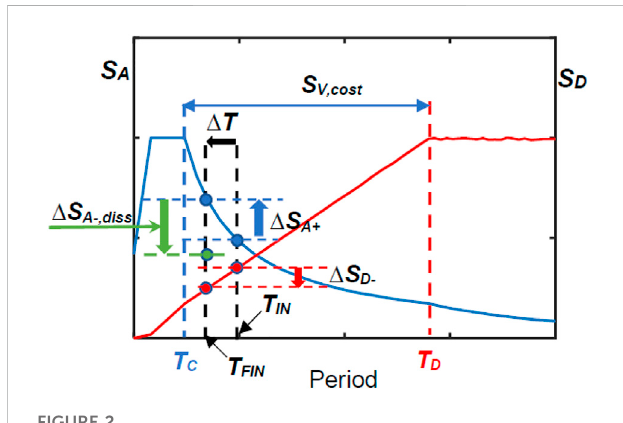
FIGURE 2 Spectral quantities involved in the sizing